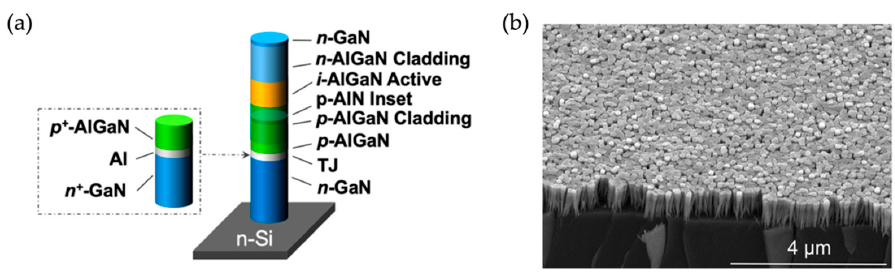
Figure 1. ( a ) Schematic of an individual AlGaN nanowire used for the large-area AlGaN nanowire tunnel junction deep ultraviolet light-emitting diodes (UV LEDs). ( b ) SEM image of the AlGaN nanowires at a large scale [70].